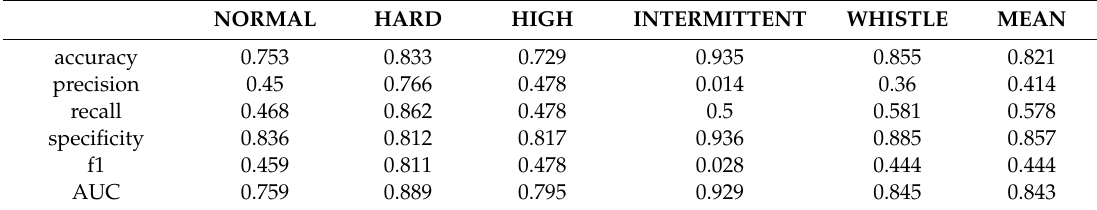
Table 5. Final score. The final score is obtained by ensembling a plurality of models in which the best score is recorded for each sound using a technique called stacking and using the final stage model. The correct answer rate for the test data was unknown 72–93% (average 82%), and the AUC was 0.75–0.92% (average